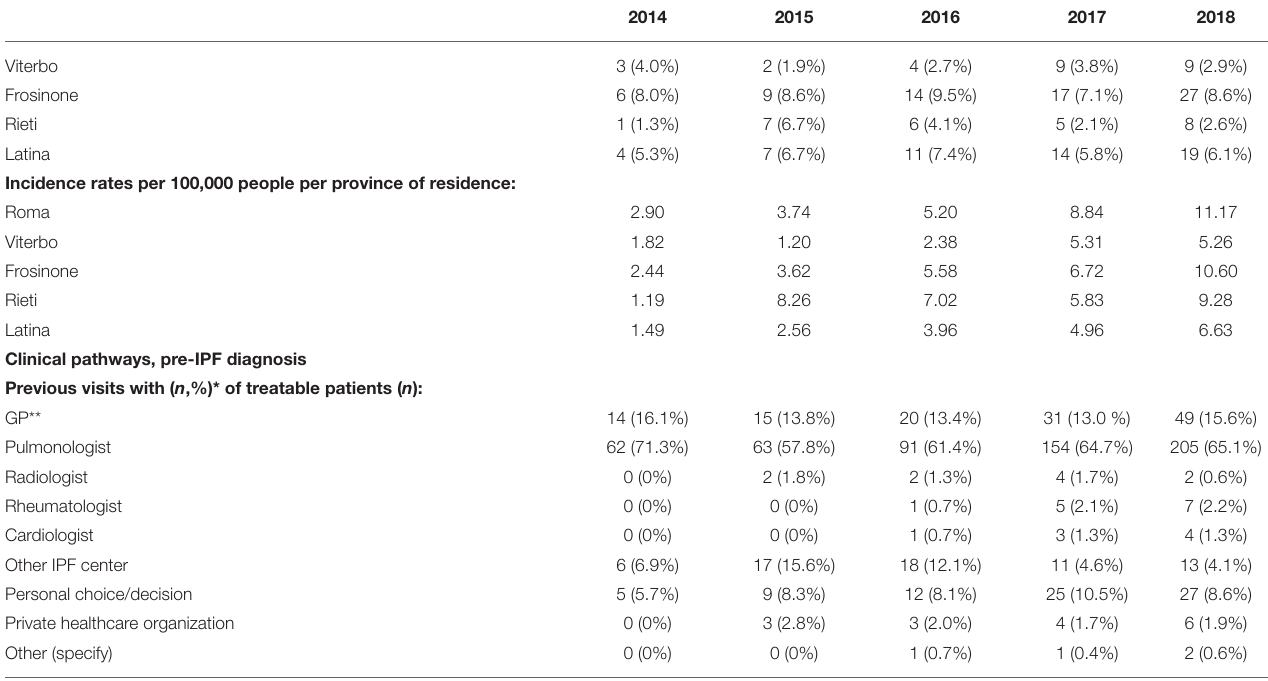
to 28.1 per 100,000 (CI 95%, 27.129.2) in individuals 75 years of age or older. The discrepancies are due not only to different timeframes (2005–2009), data sources, and criteria used to